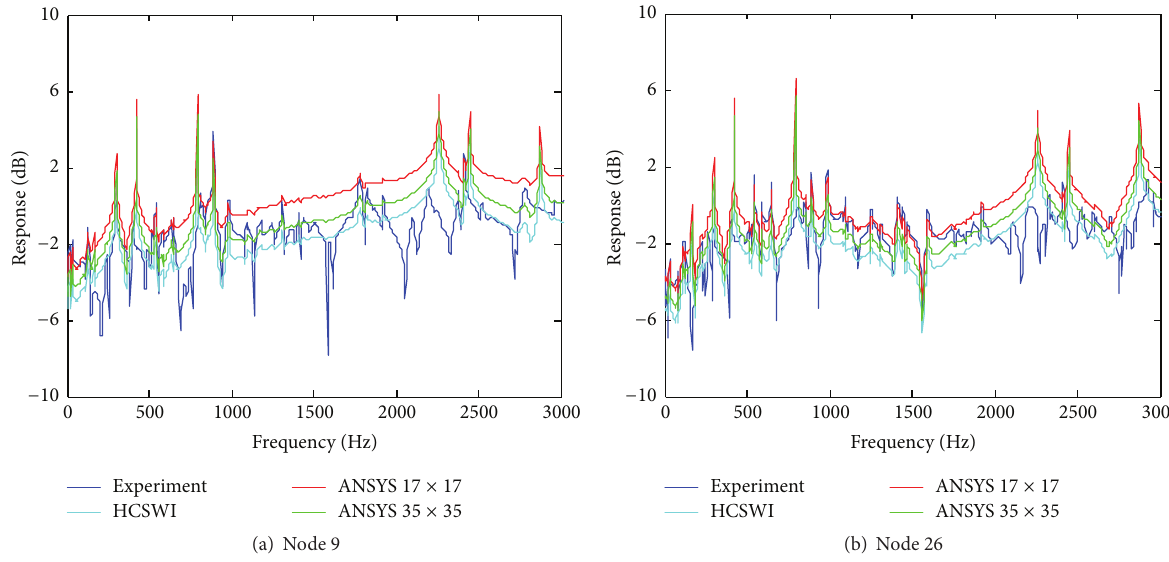
Figure 22: Acceleration FRF with the excitation at nodes 9 and 26 and the response at node